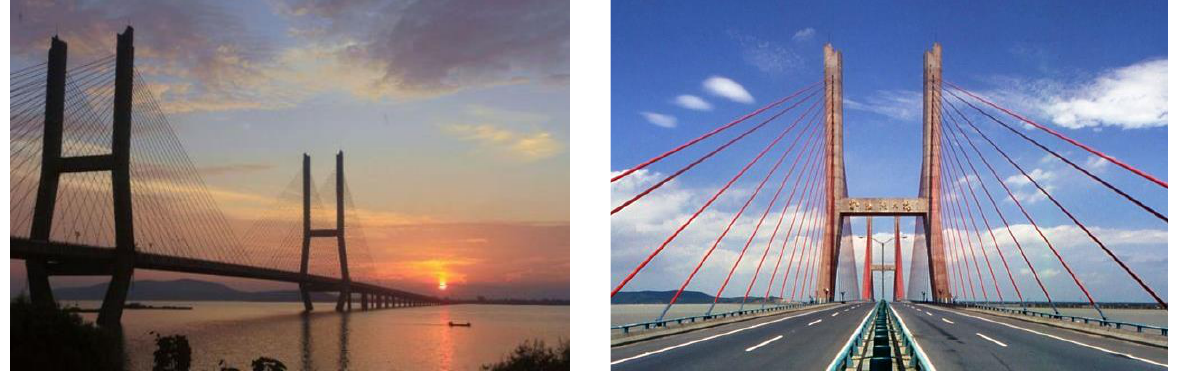
Figure 13. the overview of Poyang bridge.